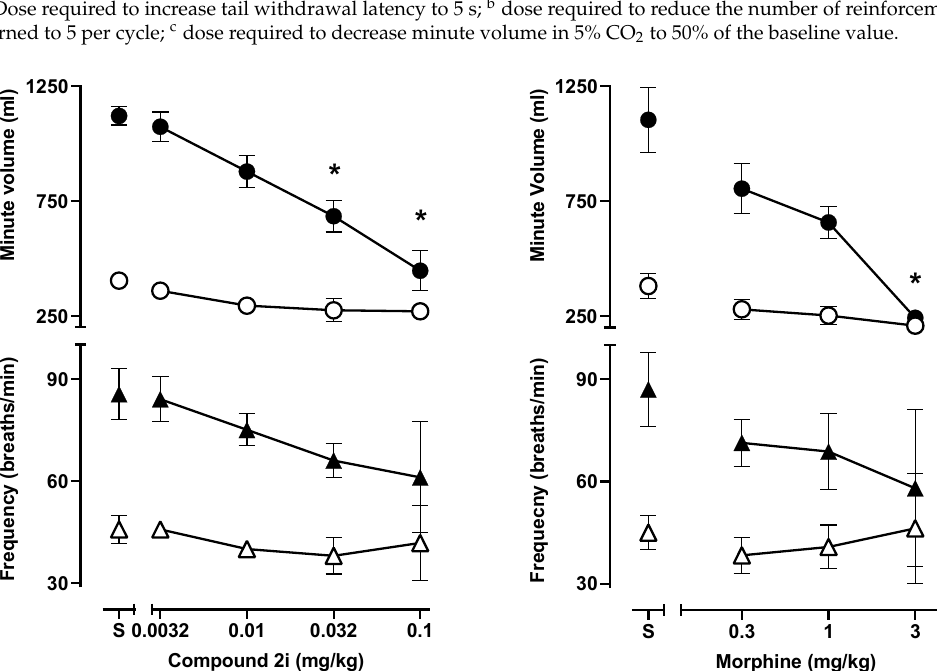
Figure 5. Effects in squirrel monkeys of 2i and morphine on respiratory rate (bottom panels) or on minute volume (top panels) in the presence of normal air (open symbols) or air mixed with 5% CO 2